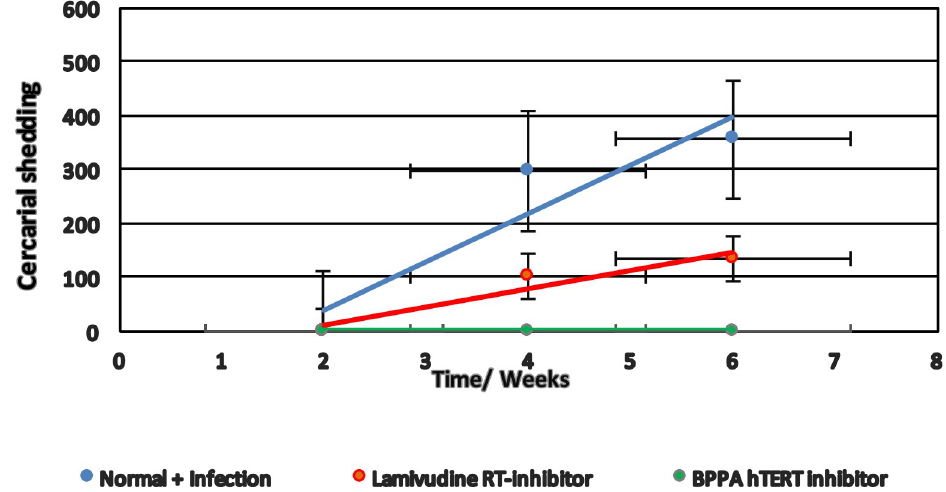
interphase nuclei of the host snail cells, correlated with gene up-regulation [13,19,40], with notable differences in gene movement between susceptible and resistant snails. We have been able to demonstrate again that gene loci change their non-random nuclear location with changes in gene expression. A FISH probe containing the sequences for B . glabrata PIWI was employed to delineate the nuclear position of the piwi gene loci in three snail strains, BS-90 (resistant) and the two susceptible strains, BB02 and NMRI (Fig 14A–14F). The nuclear posi- tioning of the gene loci were analyzed using the erosion analysis script for gene and chromo- some positioning, we have used previously for different species [41–43] and can be assigned to a peripheral (Fig 14A), intermediate (Fig 14B) or internal (Fig 14C) location in cell nuclei.